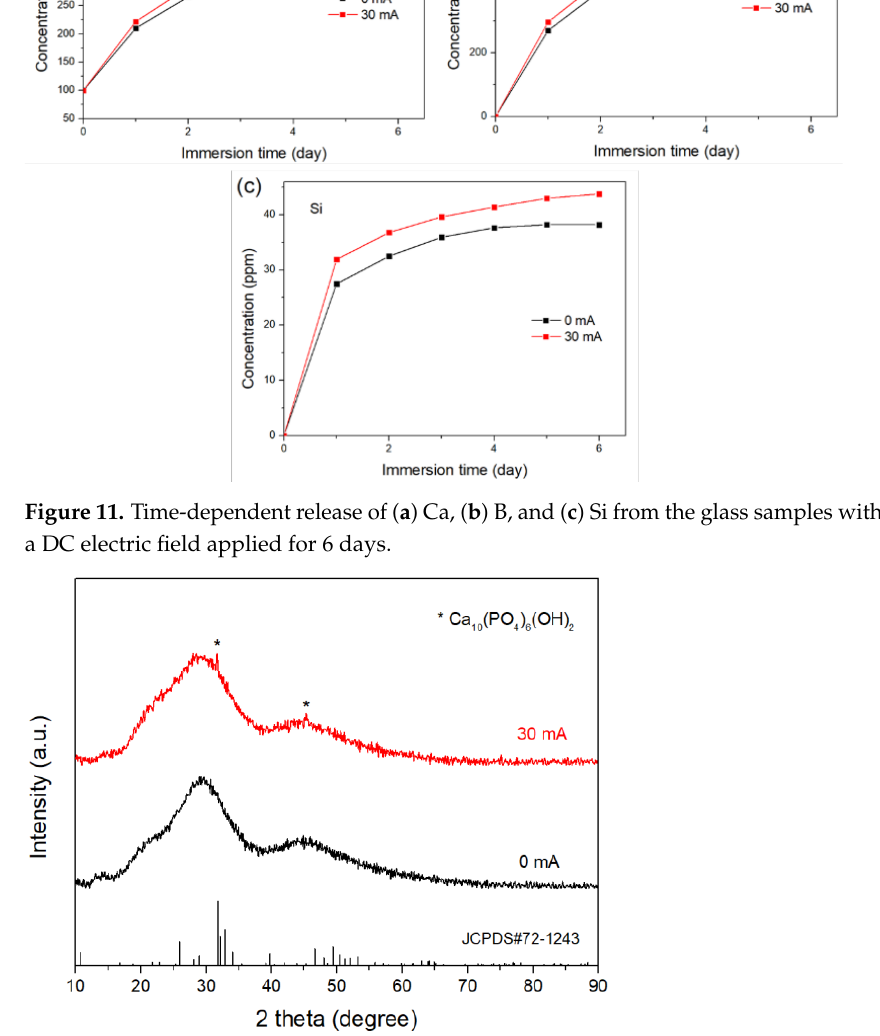
Figure 12. XRD patterns of the glass samples after immersion in SBF for 6 days.